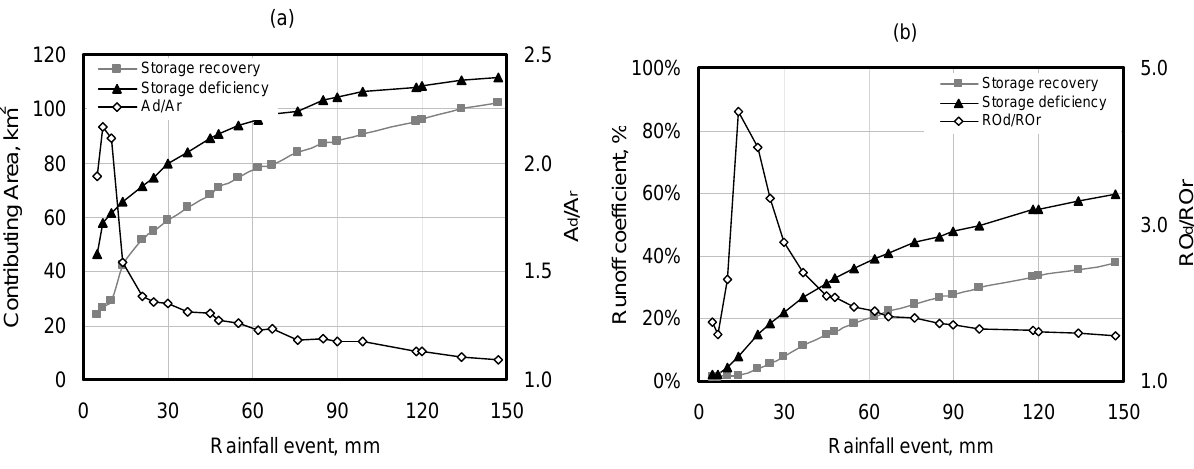
Fig. 8. Variation in (a) catchment contributing areas and (b) runoff coefficient, associated with these areas for various daily rainfall; here RO d and RO r are runoff coefficients under storage deficiency and storage recover stages, respectively, and A d and A r are contributing areas during those stages.